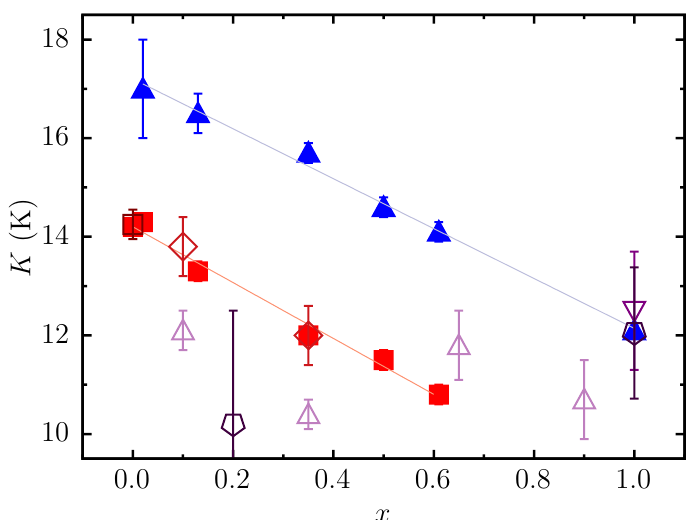
Figure 11: Kinetic energies as a function of 3 He concentration x . The solid squares and triangles represent our 4 He and 3 He results, respectively. The empty symbols refer to the most recent experimental data. For 3 He: empty triangles are from [ 93 ] ; the upside down triangle is from [ 94 ] ; the pentagons are from [ 102 ] . At x = 1.0 (pure 3 He), our result and an experimental value from [ 102 ] are indistinguishable in the figure. For 4 He: diamonds are from [ 93 ] ; the empty square is from [ 88 ] . The diamond at x = 0.35 and the empty square at x = 0.0 (pure 4 He) are indistinguish- able from our results; lines are guides to the